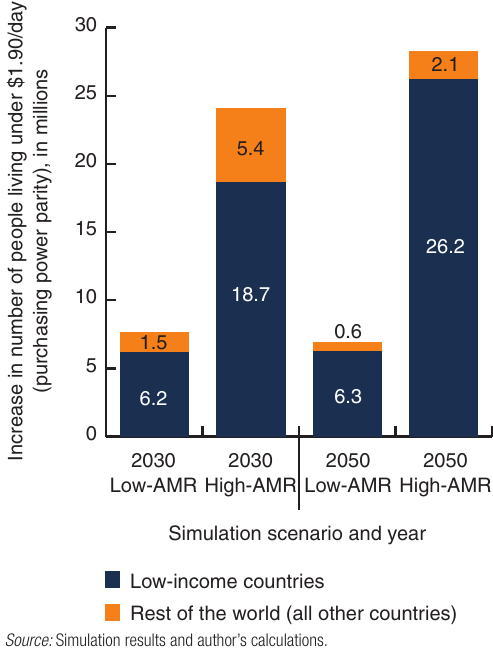
FIGURE 7. Most of the People Falling into Extreme Poverty Because of AMR Will